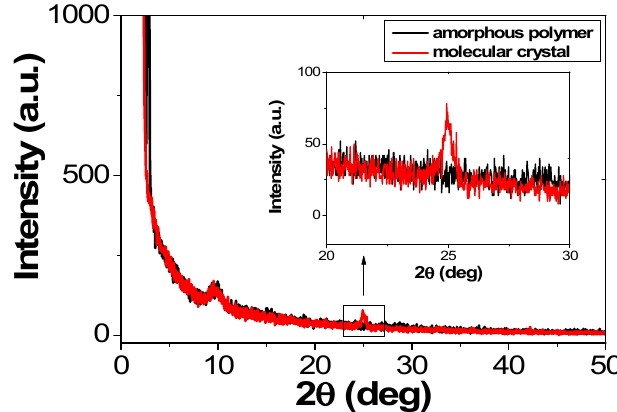
Figure 6. Measured XRD data of MEH-PPV film.